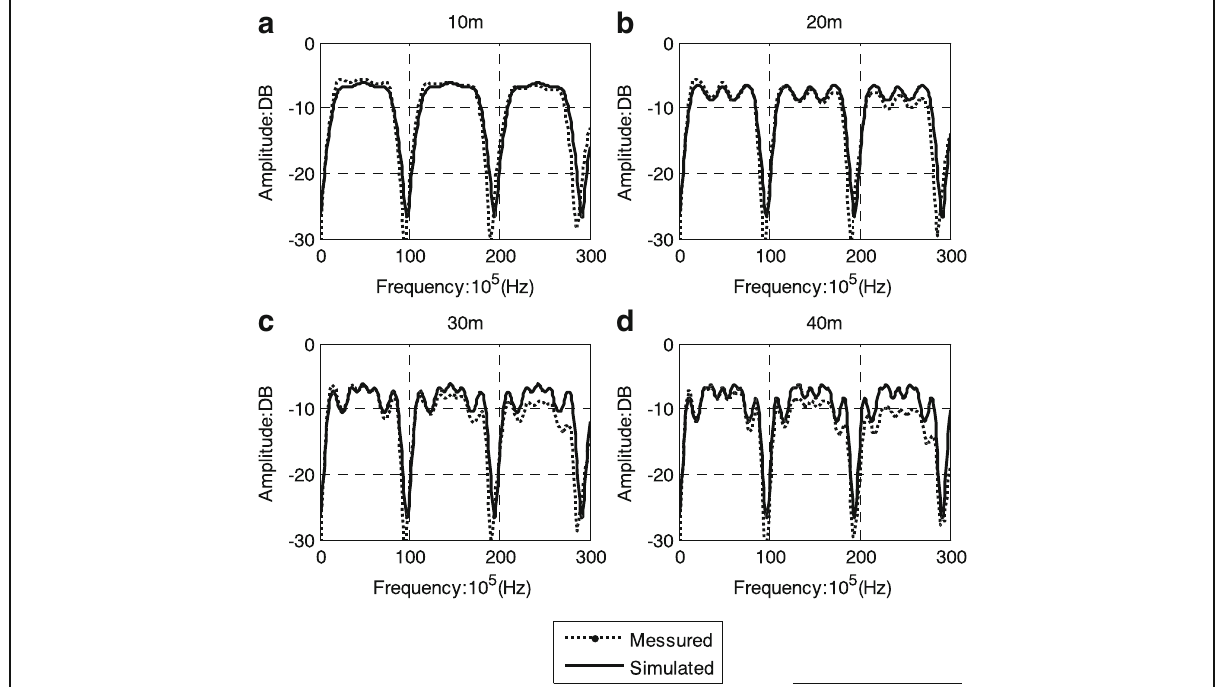
Fig. 12 Voltage transmission amplitude-frequency characteristic for various trunk lengths ( a ) 10m ( b ) 20m ( c ) 30m ( d )